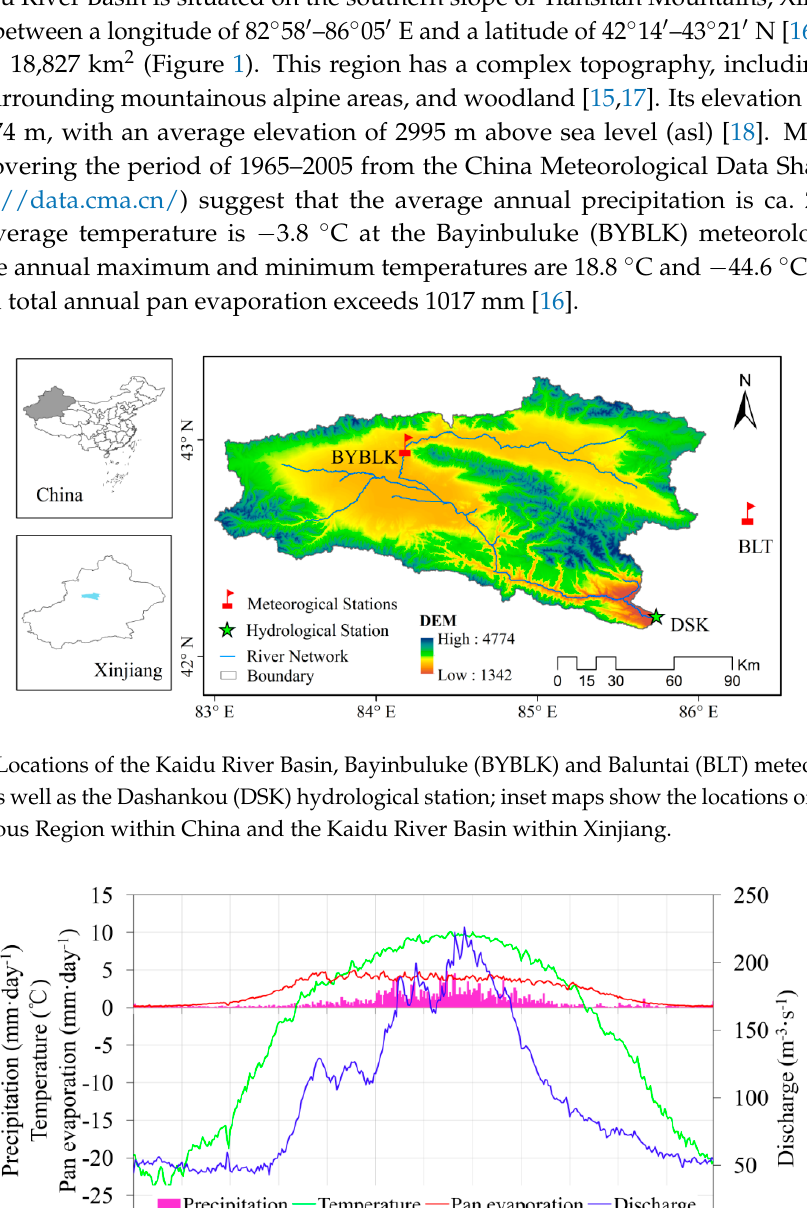
Figure 2. Mean daily precipitation, temperature, and pan evaporation at the BYBLK station and discharge at the DSK station.